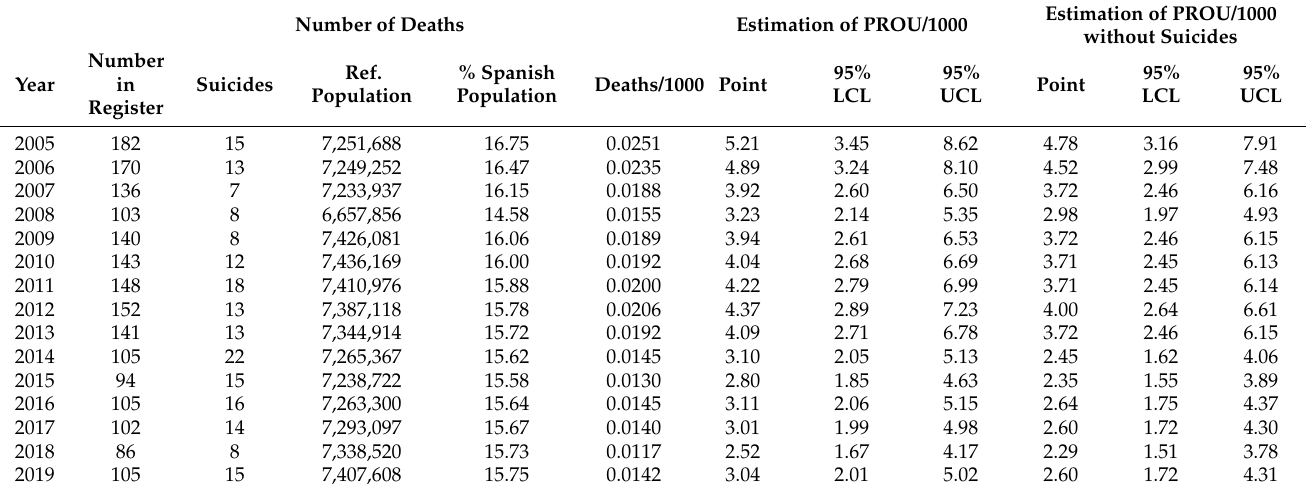
Table 1. Estimation of the prevalence of recreative opioid use in the six most populated Spanish cities. Number of Deaths Estimation of PROU/1000